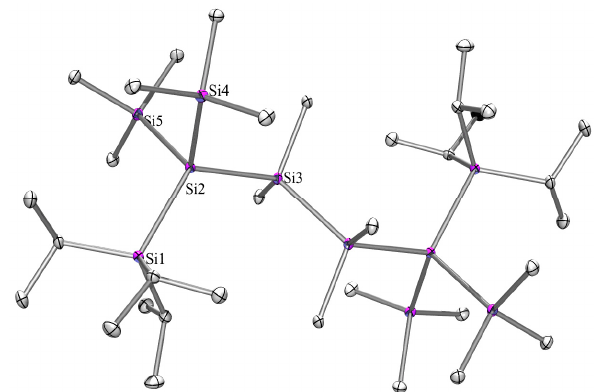
Figure 11 . Crystal structure of 9 . Thermal ellipsoids are represented at the 30% level and hydrogen atoms have been omitted for clarity (bond lengths in Å, angles in deg). Si(1)-C(1) 1.9106(17), Si(1)-Si(2) 2.3945(7), Si(2)-Si(4) 2.3764(7), Si(2)-Si(3) 2.4043(9), Si(3)-Si(3A) 2.3943(9), Si(4)-Si(2)-Si(5) 103.71(3), Si(4)-Si(2)-Si(1) 112.86(3), Si(5)-Si(2)-Si(1) 108.66(3), Si(4)-Si(2)-Si(3) 108.10(3), Si(5)-Si(2)-Si(3) 103.58(2), Si(1)-Si(2)-Si(3) 118.52(3), Si(3A)-Si(3)-Si(2) 121.66(3).